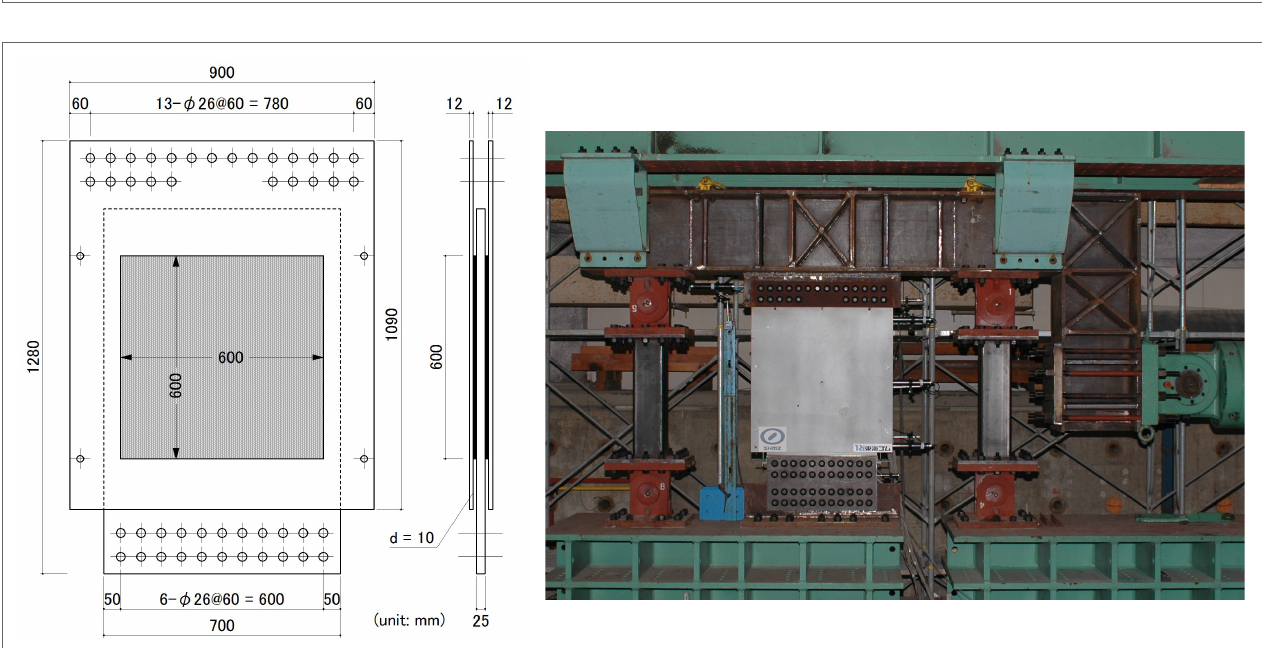
FIGURE 10 | Schematic diagram of a VED and setup of dynamic loading test .